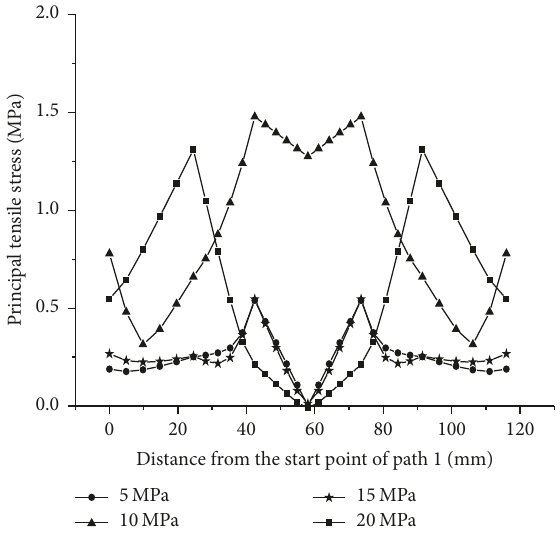
Figure 21: Comparison of the principal tensile stress generated along path 1 from corrosion-induced expansion when the dis- placement resulting from corrosion-induced expansion reaches 0.022 mm.